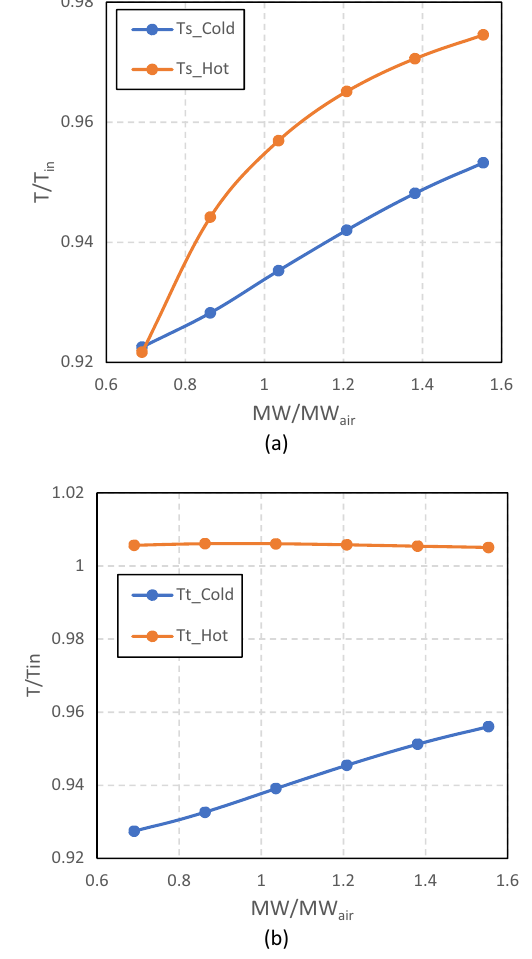
Fig. 7 Effect of molecular weight ratios on dimensionless a static and b total outlet temperatures with 400 kPa at the inlet, 0 kPa at the cold outlet and 30 kPa at the hot outlet